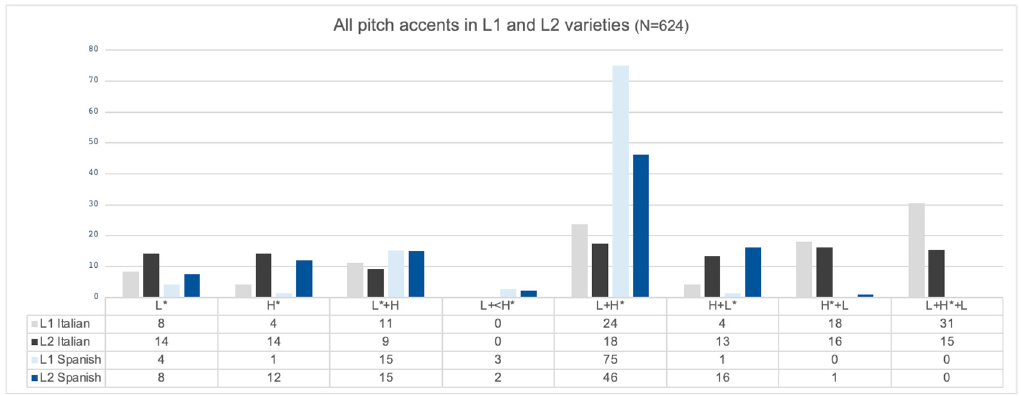
Figure 13. Tonal patterns of all pitch accents found in all L1 and L2 data (in %).